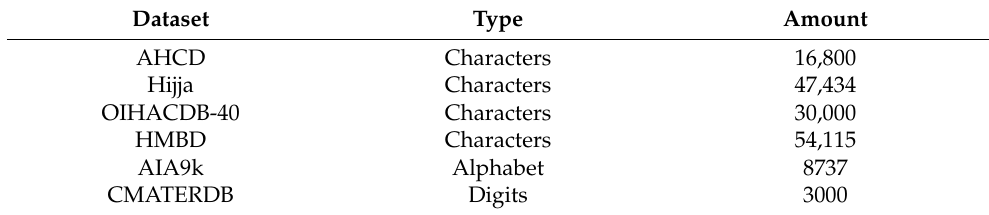
Table 2. Summary of the Arabic handwriting